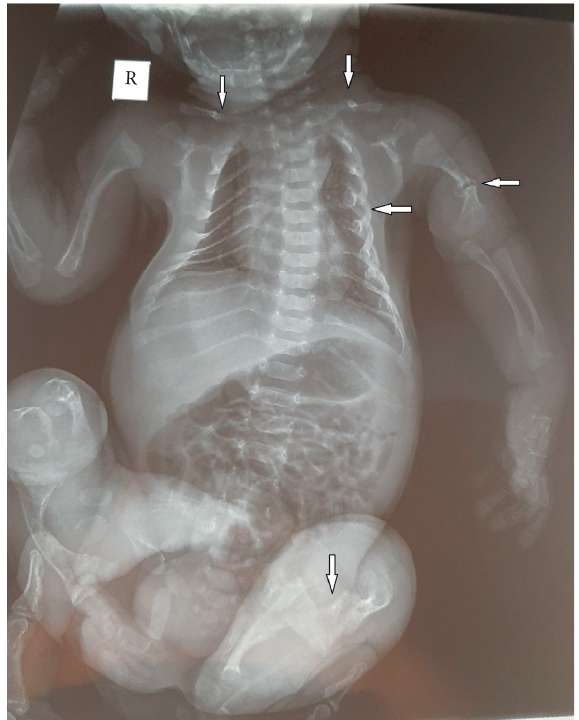
Figure 2: Plain radiograph showing fractures of bilateral clavicles, left humeral diaphysis, bilateral lower limbs, and bilateral ribs which were marked in the left hemithorax (fracture lines shown by